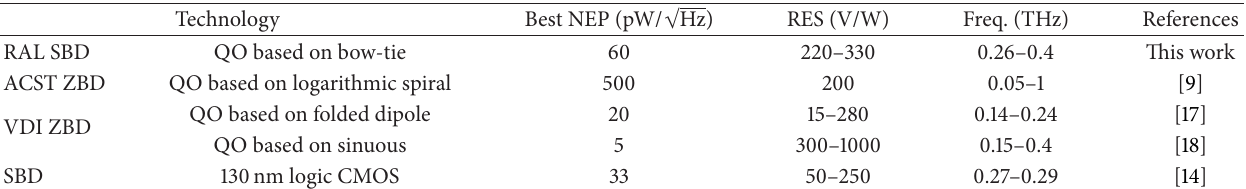
Table 1: Performance of detector compared with prior works.